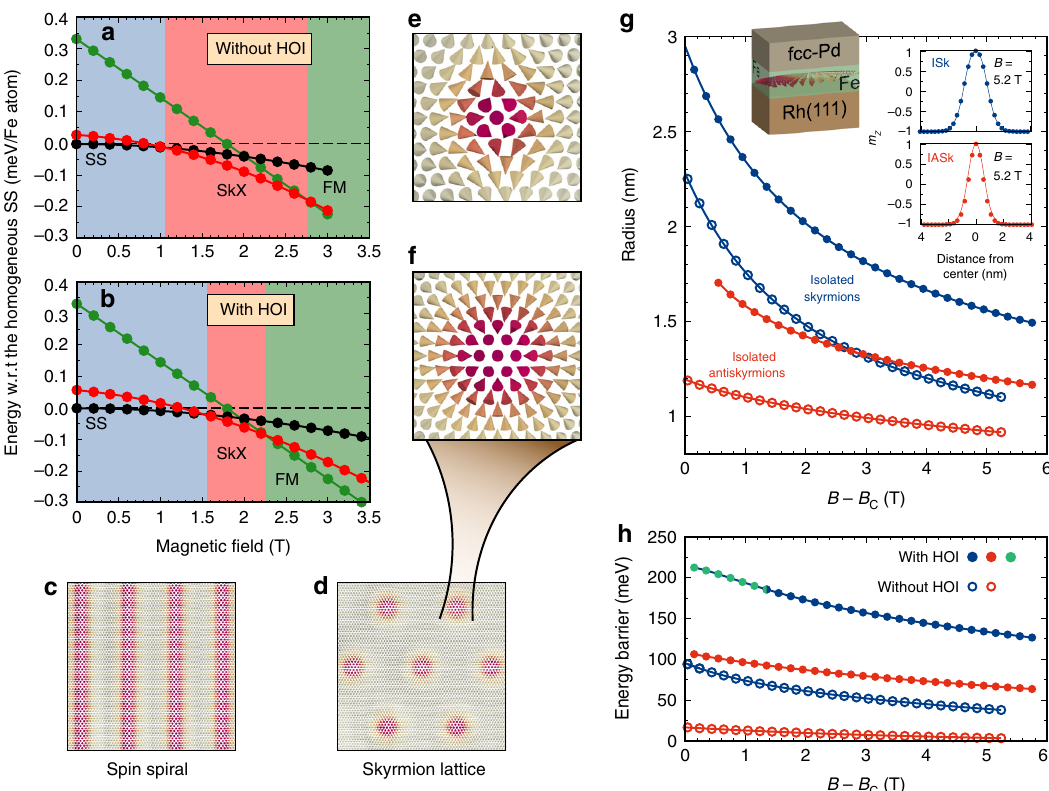
Fig. 2 Phase diagram, radius and barrier heights of Pd/Fe/Rh(111) including HOI. a , b Zero temperature phase diagram of Pd/Fe/Rh(111) obtained by neglecting and including HOI, respectively. The energy of the relaxed spin spiral (SS, black circles and line), the skyrmion lattice (SkX, red circles and line) and ferromagnetic (FM, green circles and line) fi eld-polarized state are shown with respect to the homogeneous spin spiral (black dashed line). The SS, SkX, and FM phases are denoted by blue, red and green background color, respectively. c – f Equilibrium spin structures of a SS, a SkX, an isolated antiskyrmion and a skyrmion, respectively. g Radius of isolated skyrmions and antiskyrmions as a function of applied magnetic fi eld with respect to the critical fi eld B c with and without taking HOI into account. The insets in g show the pro fi les of isolated skyrmions (ISk) and antiskyrmion (IASk) with HOI at B = 5.2 T. h Barrier heights of isolated skyrmions and antiskyrmions neglecting and including HOI as a function of magnetic fi eld with respect to B and green are used to distinguish two different collapse mechanisms of isolated skyrmions. Above B − B c = 1.36 T, isolated skyrmions (including HOI) annihilate by the radial collapse mechanism (solid blue circles) and below B − B c = 1.36 T, they annihilate via a chimera structure at the saddle point (solid green circle) and at 1.36 T, they can annihilate by both mechanisms (solid blue – green